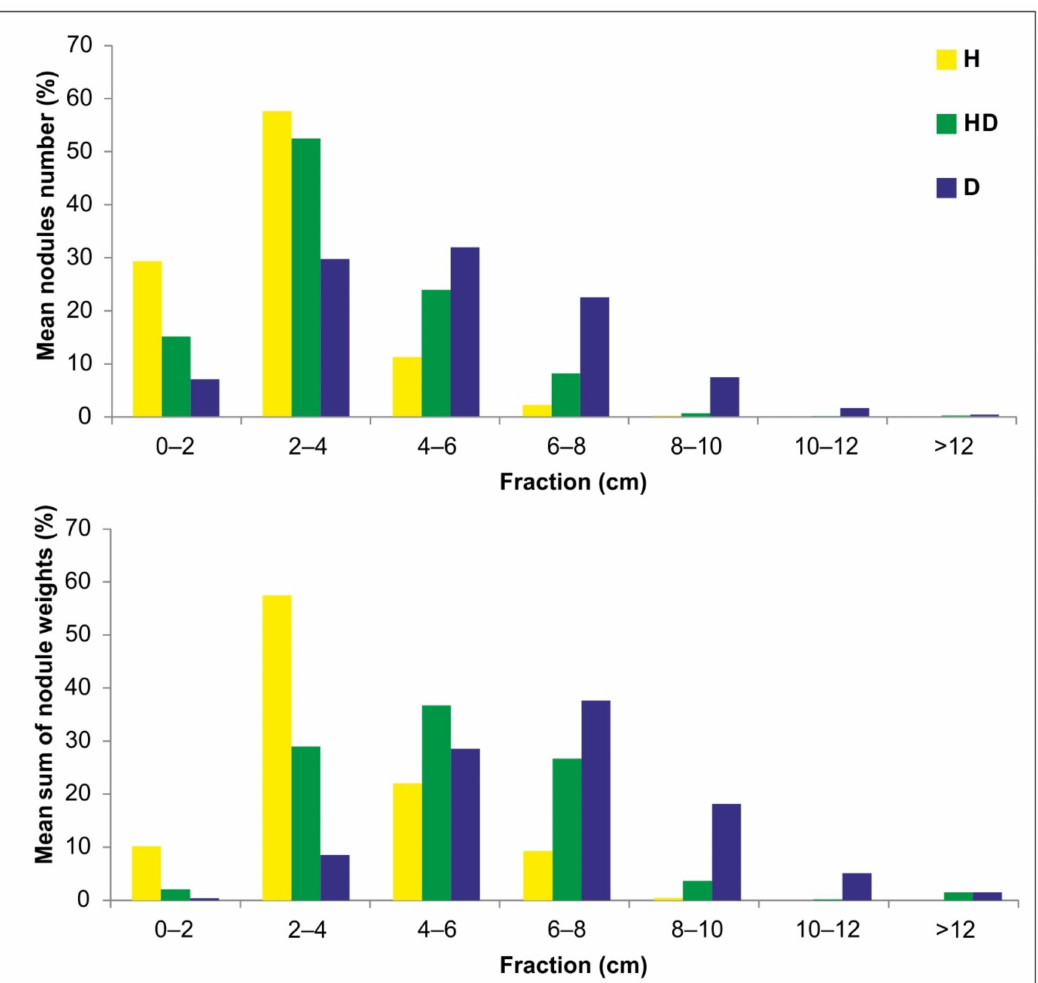
Figure 10. Distributions of the mean number of nodules ( top ) and the mean sum of nodule weights ( bottom ) defined on the basis of the box corer samples from all 68 sampling stations in the H22 exploration